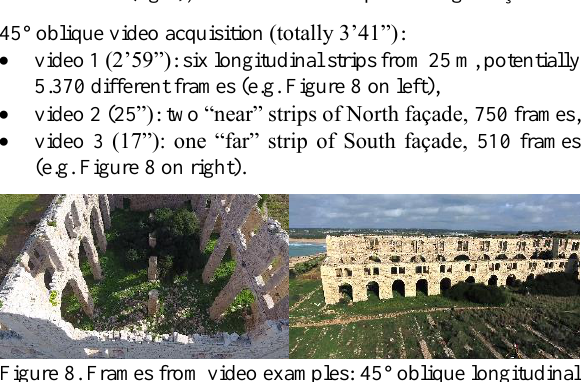
Figure 7. Image examples: 45° oblique transversal (left) and horizontal (right), this last from a strip on a single façade.